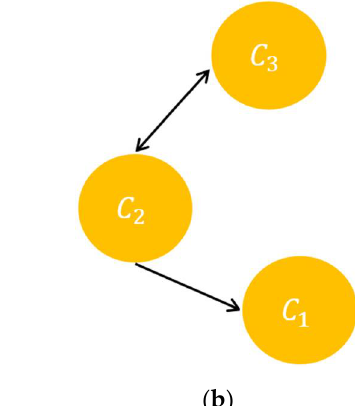
Figure 7. Access policies. ( a ) hierarchical classes; ( b ) flexible classes. Table 2. The parameters of C j for Figure 7b.